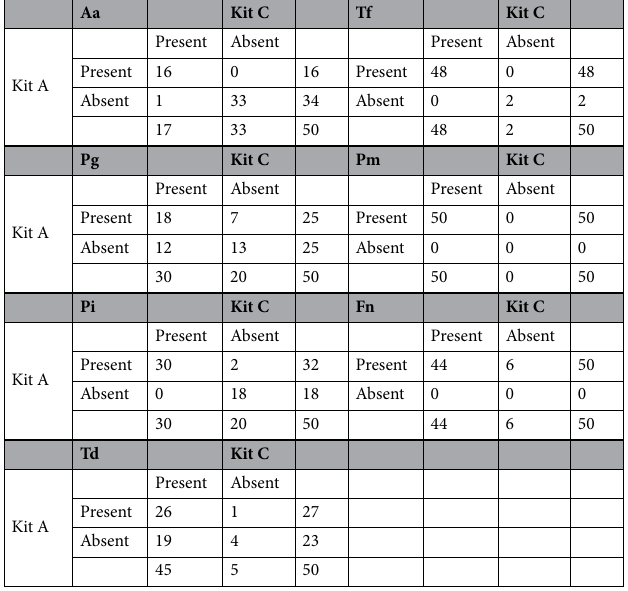
Table 5. Detection frequency of periodontal pathogens by two different test kits A and C.